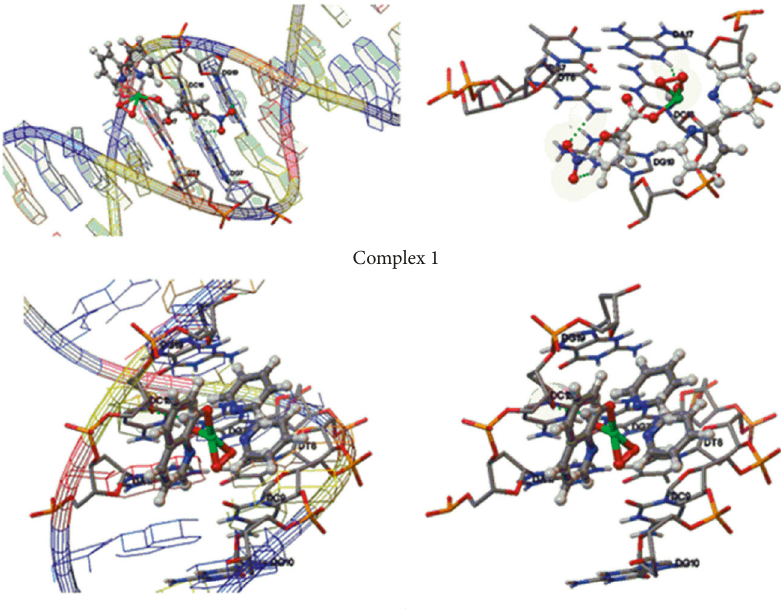
Figure 19: Docked conformations of the complexes complex 1 (top) and complex 2 (bottom) with the crystal structure of the E2 binding region of DNA (PDB ID: 423D). The compounds are represented in the ball and stick model. The green dotted line represents the hydrogen bonds between the metal complex and